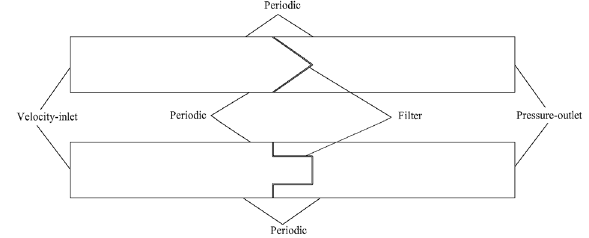
Figure 4. Numerical simulation computational region.